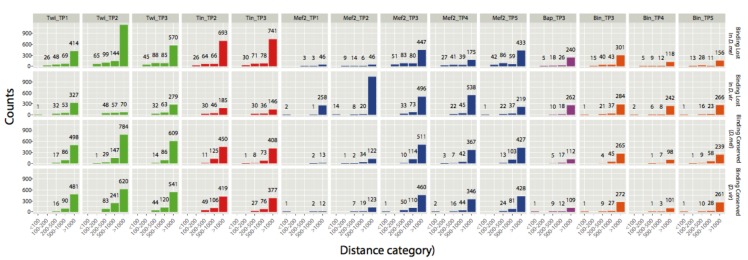
Count of CRMs with a close binding event falling in one of the five distance categories.y-axis shows absolute counts (also displayed as numbers above corresponding bars) and x-axis the 5 distance categories. The analysis was done for all 4 categories of CRMs: Binding lost in D. mel, binding lost in D. virilis, binding conserved (for D. mel CRMs) and binding conserved (for D. virilis CRMs).